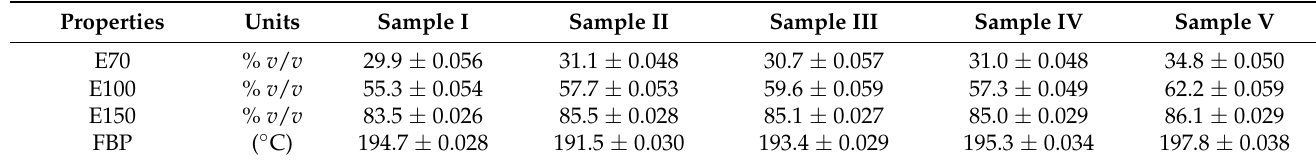
Table 7. Distillation characteristics of base fuels.